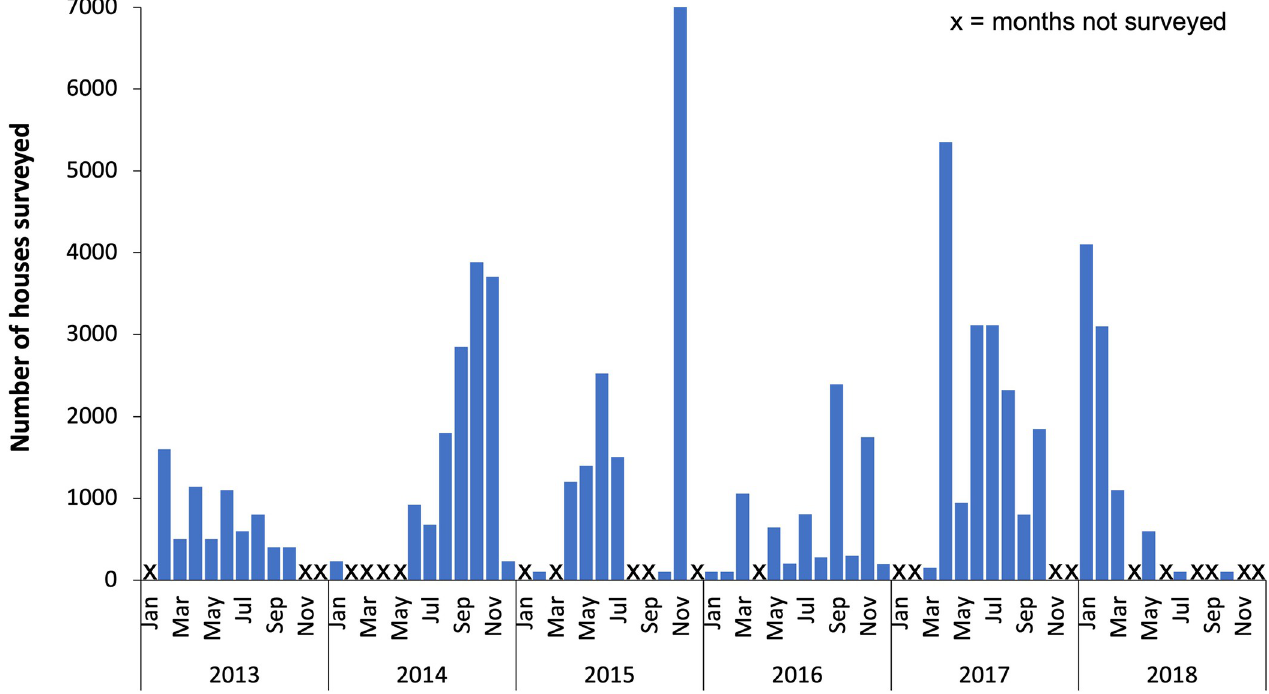
Fig 2. Temporal pattern of house surveys across the southern Philippines, 2013–2018. The monthly trend in number of houses surveyed for mosquito larvae across the southern Philippines during the 6-year period. Surveys varied in number and location each month depending on the number and duration of dengue outbreaks reported, with a total of 714 surveys conducted across the 563 villages of the 65 cities/municipalities in 49/69 months between Feb 2013 and Oct 2018.